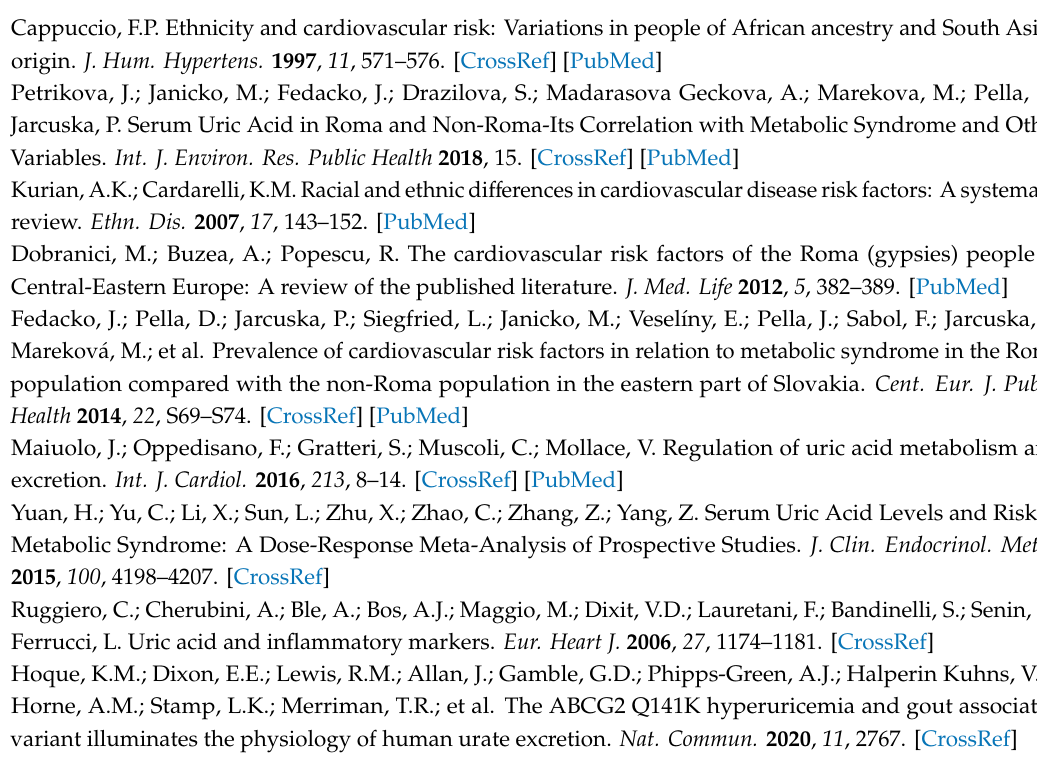
s1, Table S1: Relationship between uric acid adjusted for age, sex and BMI and dependent variables in all study